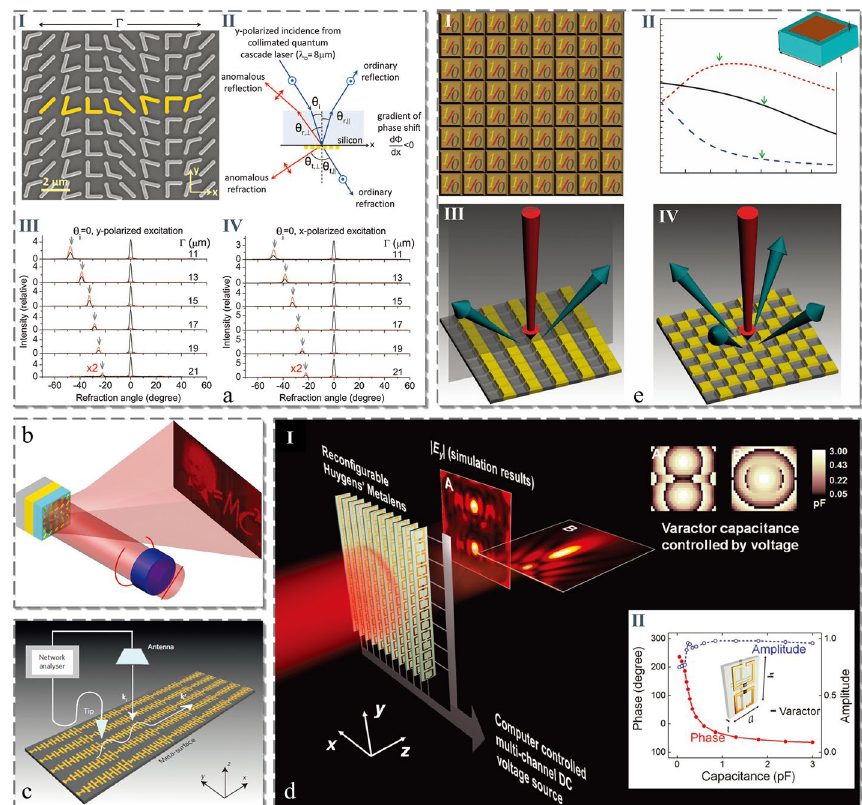
Fig. 2 (a) Light propagation with phase discontinuities: (I) Scanning electron microscope (SEM) image of a representative antenna array. (II) Schematic experimental setup for y -polarized excitation (electric field normal to the plane of incidence); (III and IV) Measured far-field intensity profiles of the refracted beams for y - and x -polarized excitations. (b) Illustration of a reflective nanorod-based computer-generated hologram for a circularly polarized incident beam. (c) Schematic description of a specific gradient index metasurface that can convert a propagating wave into a surface wave with nearly 100% efficiency. (d) Reconfigurable Huygens’ meta-lens and characteristics of meta-atom: (I) Active Huygens’ meta-lens for dynamic electromagnetic wave focusing. Upper-right inset: spatial distribution of the capacitances used to achieve two focal spots; (II) Capacitance-dependent phase and amplitude responses of electromagnetic wave transmission for incident electric and magnetic fields. (e) 1-bit digital metasurface and coding metasurface: (I) 1-bit digital metasurface composed of only two types of elements: ‘0’ and ‘1’; (II) A square metallic patch unit structure (inset) to realize ‘0’ and ‘1’ elements and the corresponding phase responses; (III and IV) Two 1-bit periodic coding metasurfaces for controlling the scattering of beams. (a) Reproduced with permission [47]. Copyright 2011, American Association for the Advancement of Science. (b) Reproduced with permission [61]. Copyright 2015, Nature Publication Group (NPG). (c) Reproduced with permission [62]. Copyright 2012, NPG. (d) Reproduced with permission [63]. Copyright 2017, Wiley-VCH. (e) Reproduced with permission [64]. Copyright 2014,